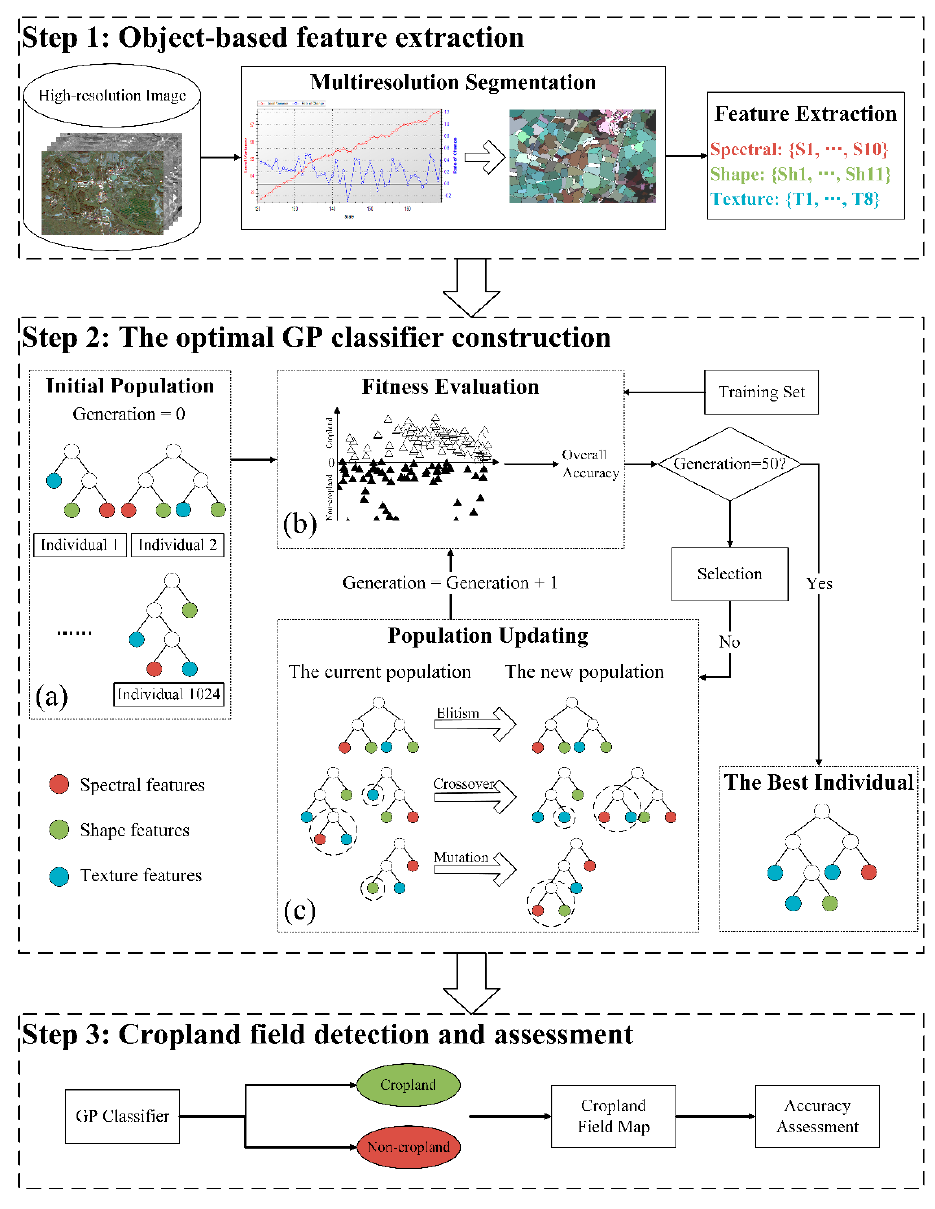
Figure 1. The flowchart of the proposed genetic programming (GP) method. The optimal GP classifier construction includes three parts, initial population ( a ), fitness evaluation ( b ) and population updating ( c ).